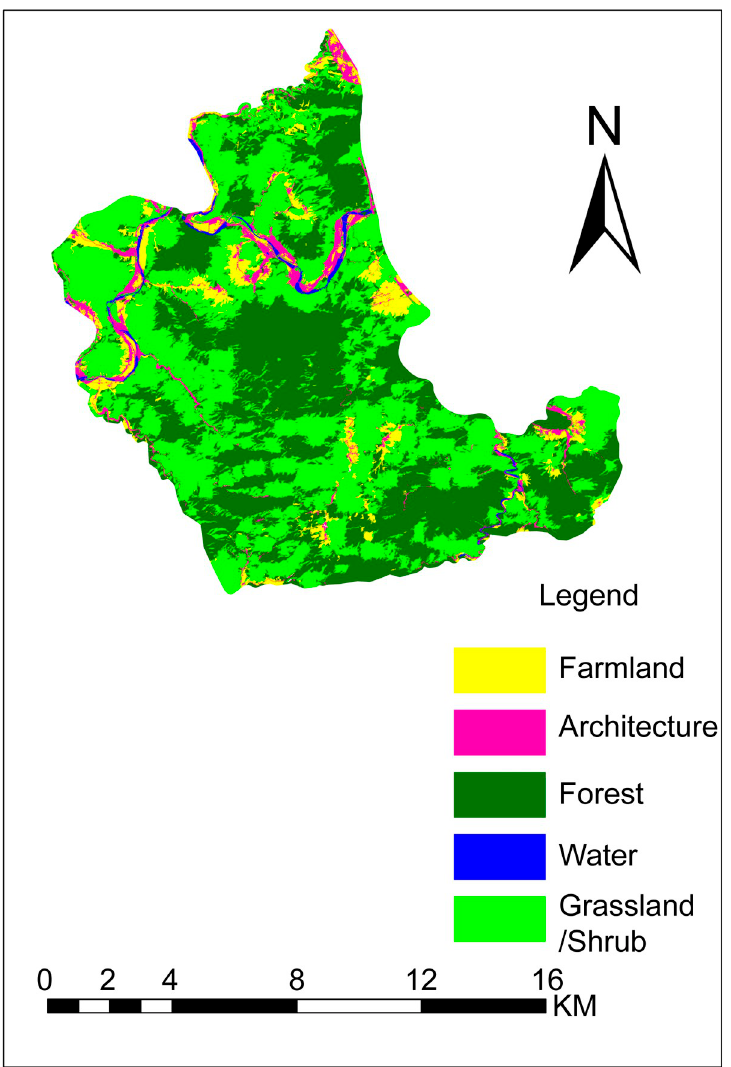
Fig 6. Object-oriented classification of Baili Gorge (Republished from [https://directory.eoportal.org/web/ eoportal/satellite-missions/g/gaofen-2] under a CC BY license, with permission from [Hebei Zhongke Sino Star Information Technology Co., Ltd], original copyright [2018]).